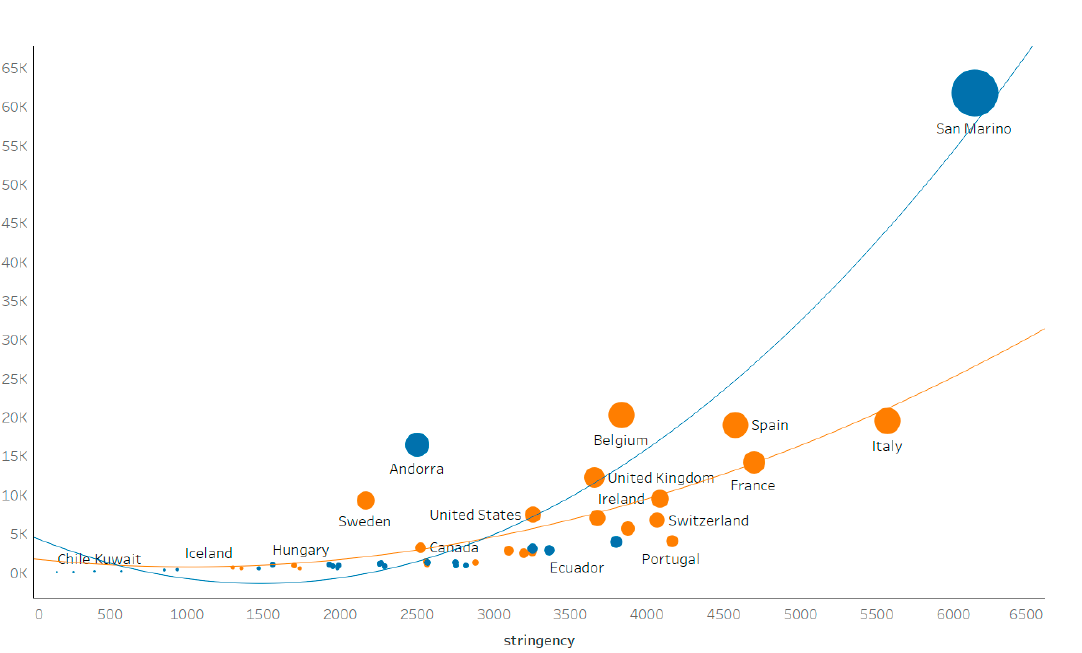
Figure 2. Scatter plot of policy stringency index and tdeaths_pm.